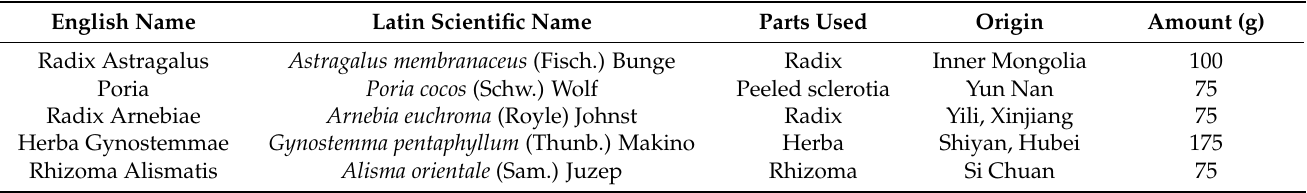
Table 1. The compositions of